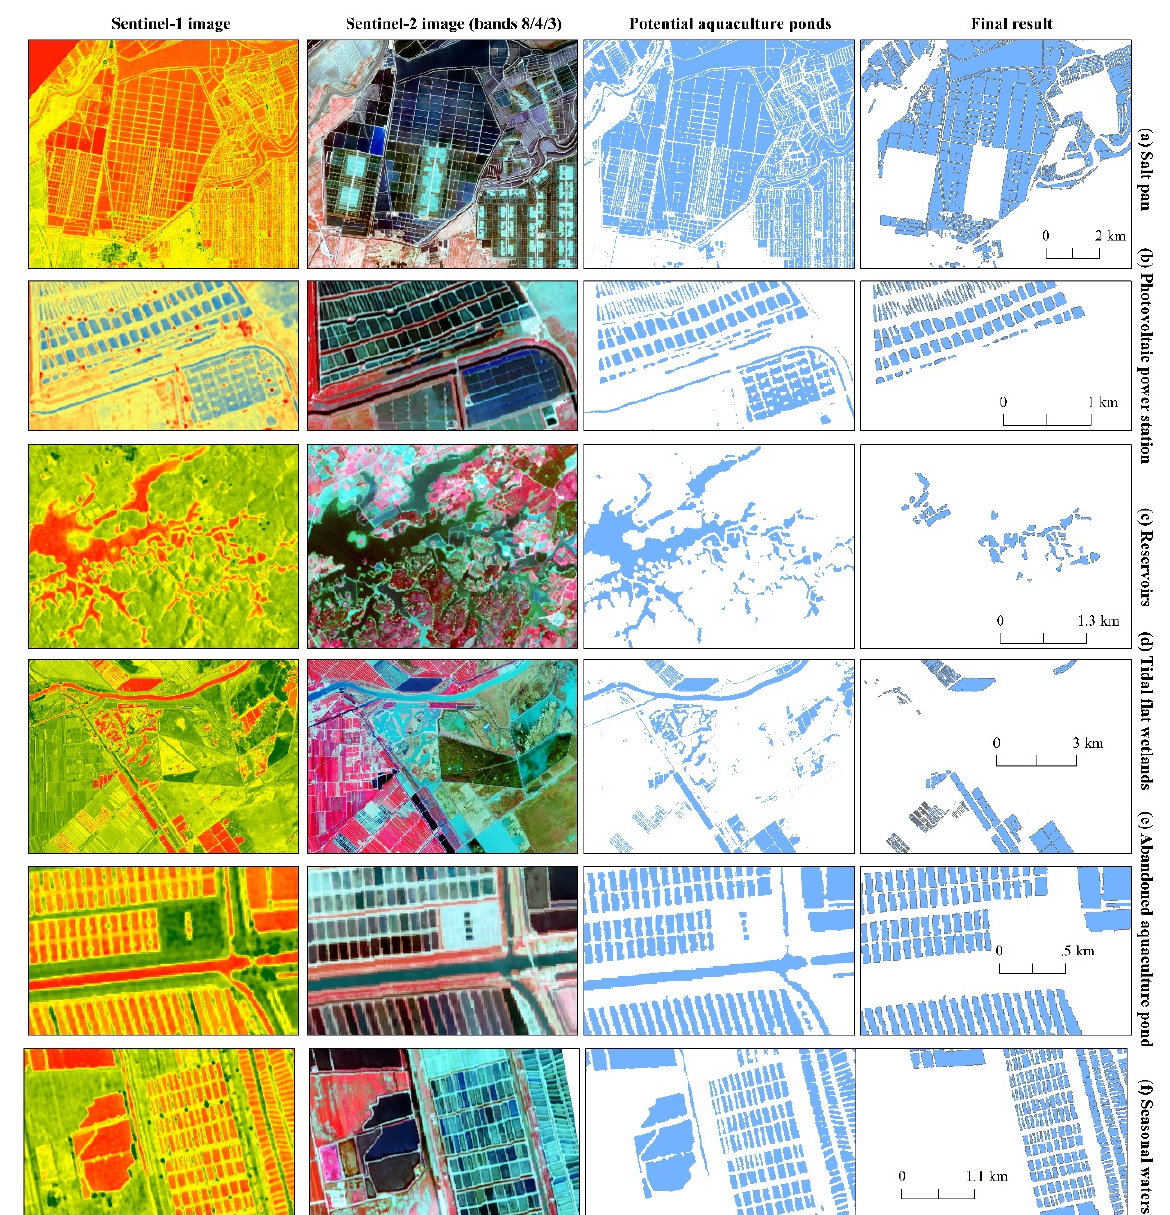
Figure 11. Sources of errors in coastal aquaculture pond extraction. The main error sources in the extraction process of aquaculture ponds were (a) salt pans, (b) photovoltaic power stations panels, (c) reservoirs, (d) tidal flat wetlands, (e) abandoned fishponds, and (f) seasonal water bodies.